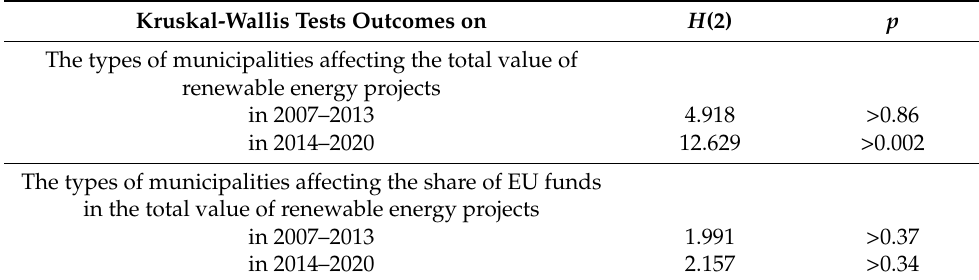
Table 5. Kruskal-Wallis tests for the type of municipalities vs. total value of renewable energy projects and the share of EU funds in the total value of renewable energy projects in 2007–2013 and 2014–2020. Kruskal-Wallis Tests Outcomes on H